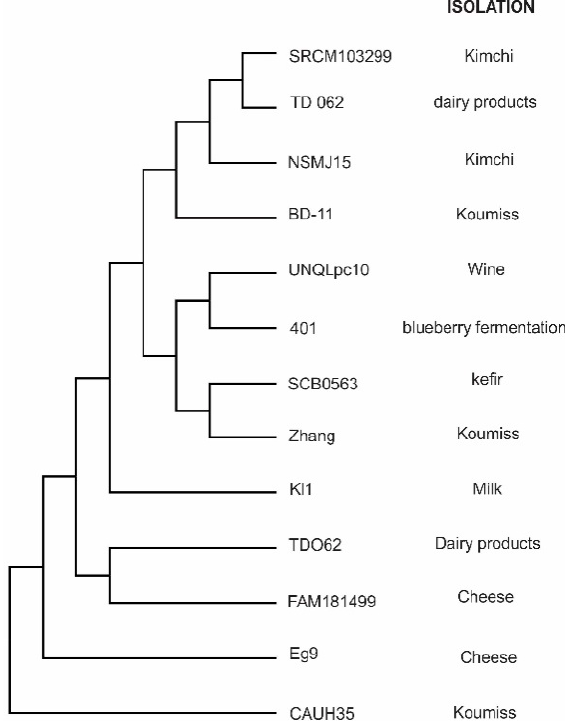
Figure 3. Core genome phylogenies, obtained by using the BGA software, from the gene content analysis of UNQLpc 10 (Patagonian red wine), and complete genomes of Lcb. paracasei strains isolated from different fermented foods (available from the NCBI GenBank database).